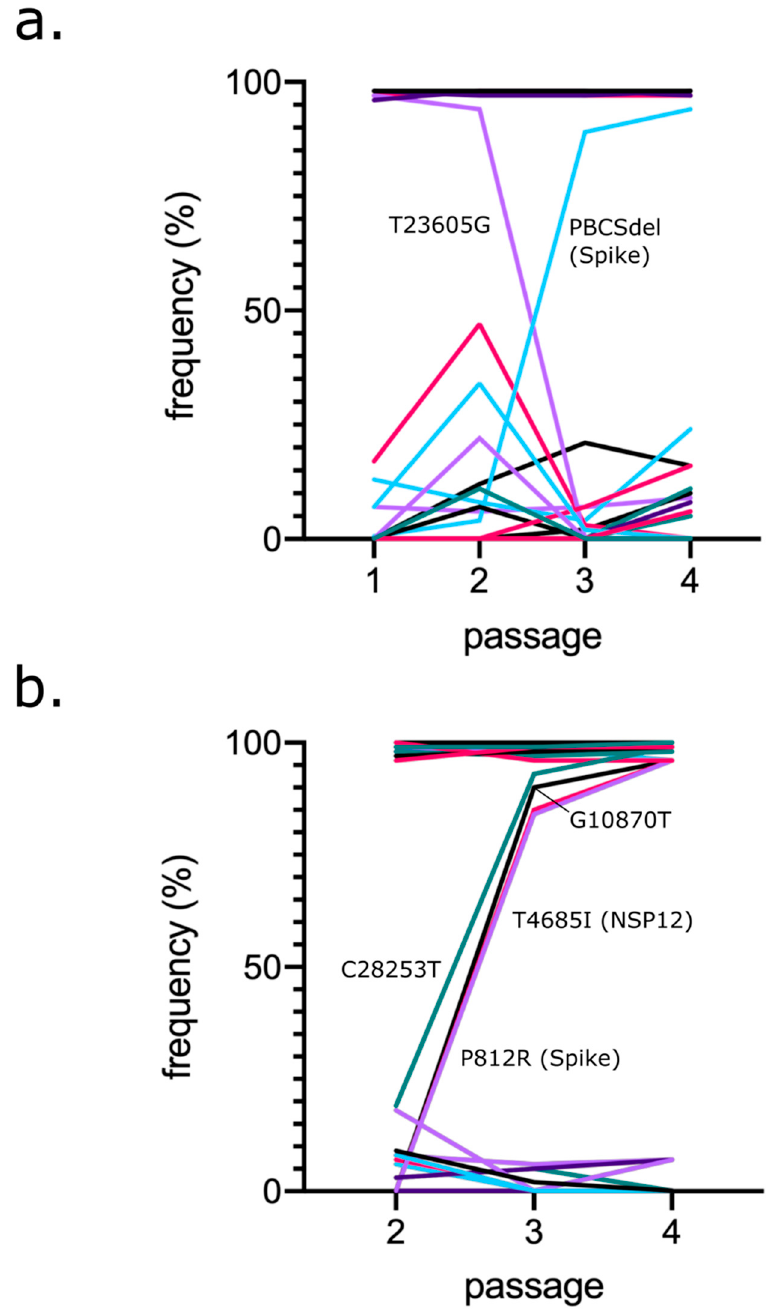
Figure 2. Analysis of PHE and BT20.1 whole-genome sequences during Vero cell passage. Frequency of mutations detected for PHE ( a ) and BT20.1 ( b ) passage series on VeroE6 or Vero cells, relative to the reference sequence (Wuhan-Hu-1). Only sequences from P1-P4 (PHE) and P2-P4 (BT20.1) were analysed to facilitate adequate comparisons. Core changes are found consistently at a high frequency and minor variants are found at consistently a low frequency (e.g., <50%). Only variants that significantly changed in frequency are marked on the graph. Colours do not reflect relationships between variants.